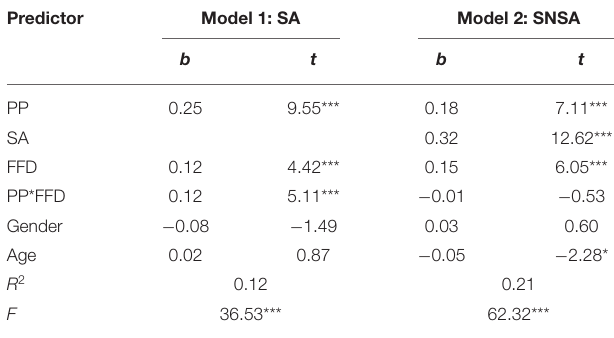
TABLE 2 | Testing the mediation effect of peer phubbing on social networking site addiction via social anxiety. Predictor